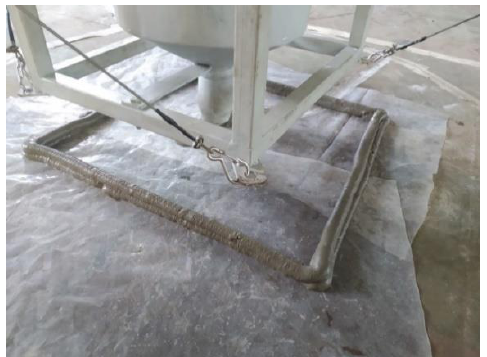
Figure 21. The two layers of square concrete of the experiment.